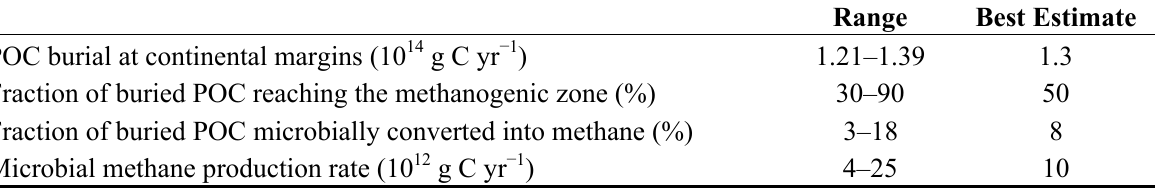
Table 1. Quaternary POC and methane balance for global continental